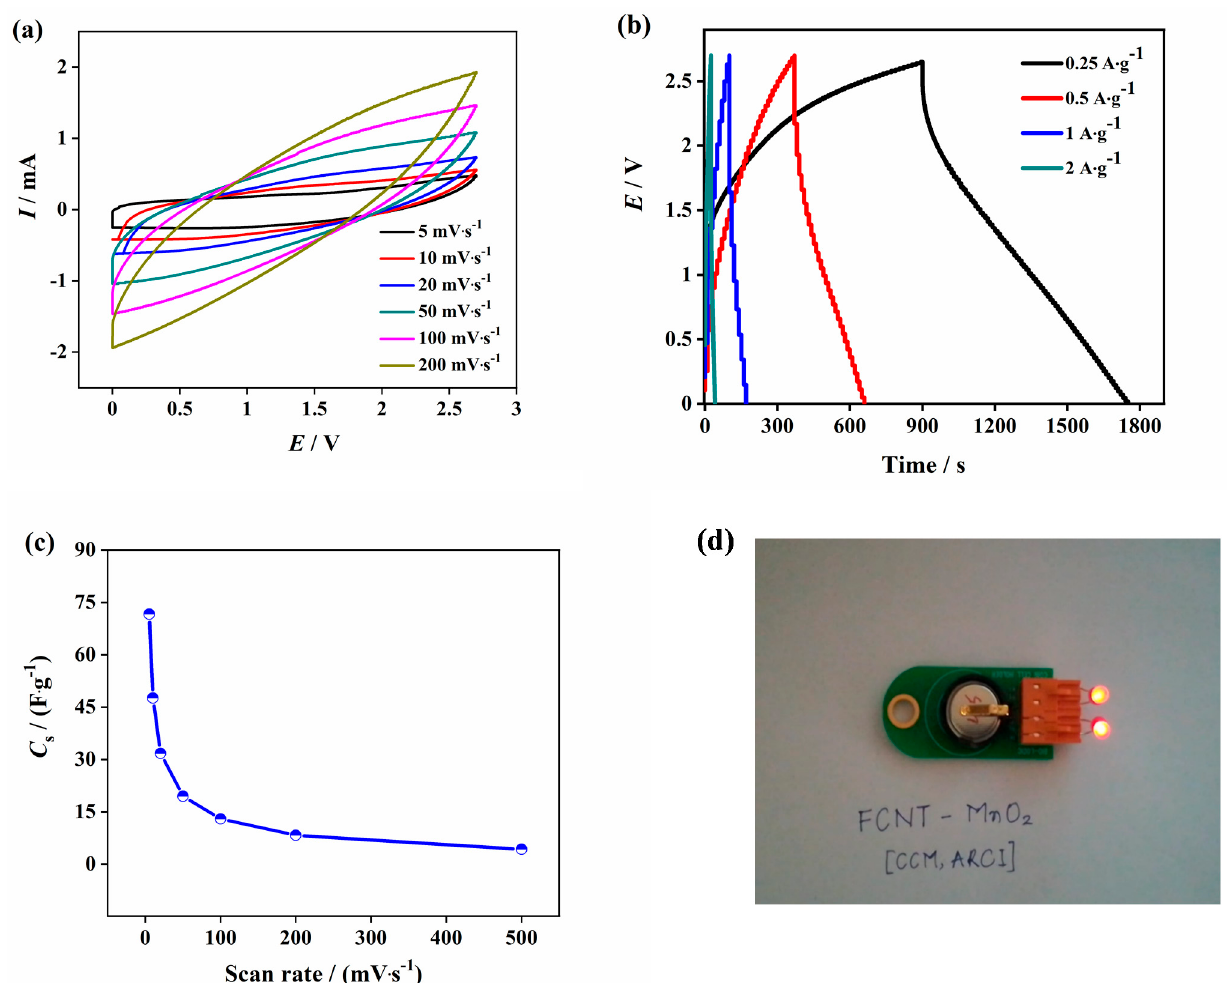
Figure 5. Electrochemical analysis of FCNT-MnO 2 in the organic electrolyte (1 M TEABF 4 in Acetonitrile (1:1)) ( a ) CV, ( b ) GCD, ( c ) specific capacitance from CV, and ( d ) LED glowing from FCNT-MnO 2 cell.